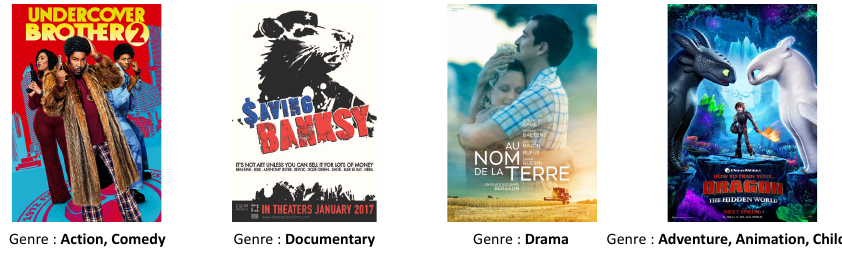
Figure 3. Examples of providing genre information ( MovieLens dataset).